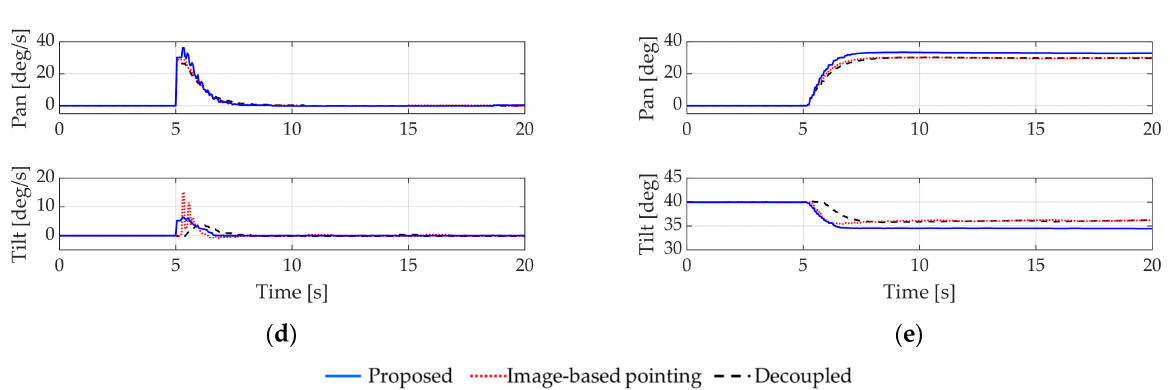
Figure 8. Experiment 1: Tracking a target initially located on the horizontal line. ( a ) Frame-by-frame tracking performance of the proposed control and the image-based pointing control; ( b ) tracking path on the image plane; ( c ) time response of each coordinate; ( d ) control signals; ( e ) orientations of the inner gimbal.